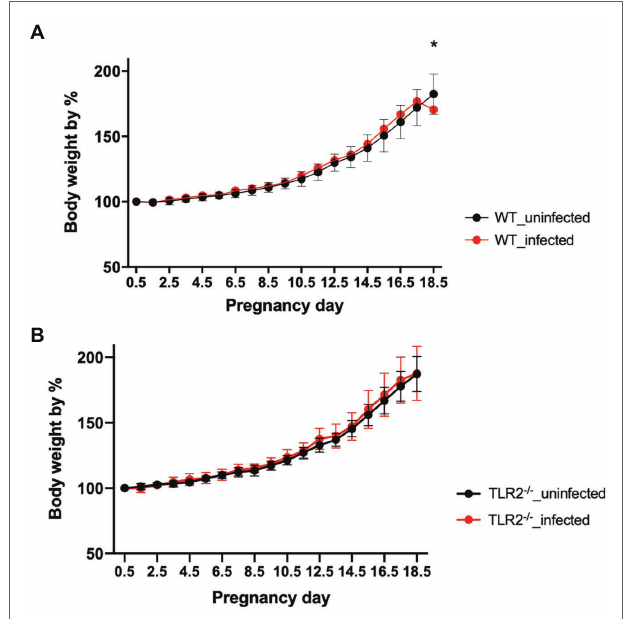
FIGURE 1 | Bodyweight changes in uninfected mice and mice infected with T. gondii . Values presented are the means ± standard deviations of each group. (A) Bodyweight changes in uninfected wild-type (WT) and T. gondii - infected WT mice. (B) Bodyweight changes in uninfected TLR2 − / − and T. gondii -infected TLR2 − / − mice. The statistical analysis was performed with two-way ANOVA and Bonferroni’s multiple-comparison test. * p <